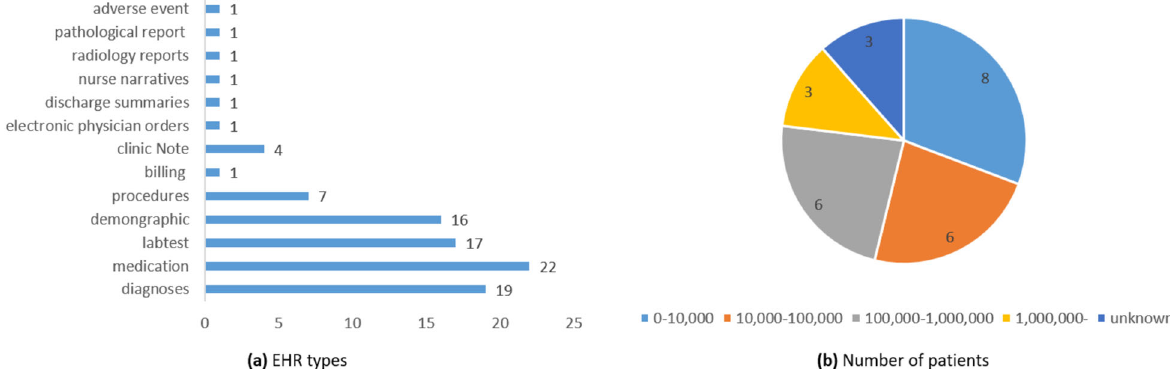
Fig. 2 Distribution of EHR types and number of patients. a shows the distribution of the EHR types, and b shows the distribution of the number of